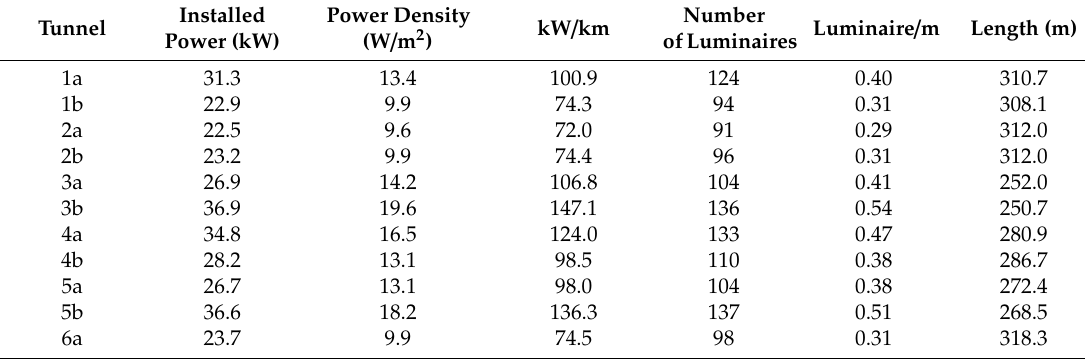
Table 10. Number of LED luminaires needed and the corresponding installed power and the energy indicators for the entrance zone of the examined tunnels for the new calculated Lth‘ luminance